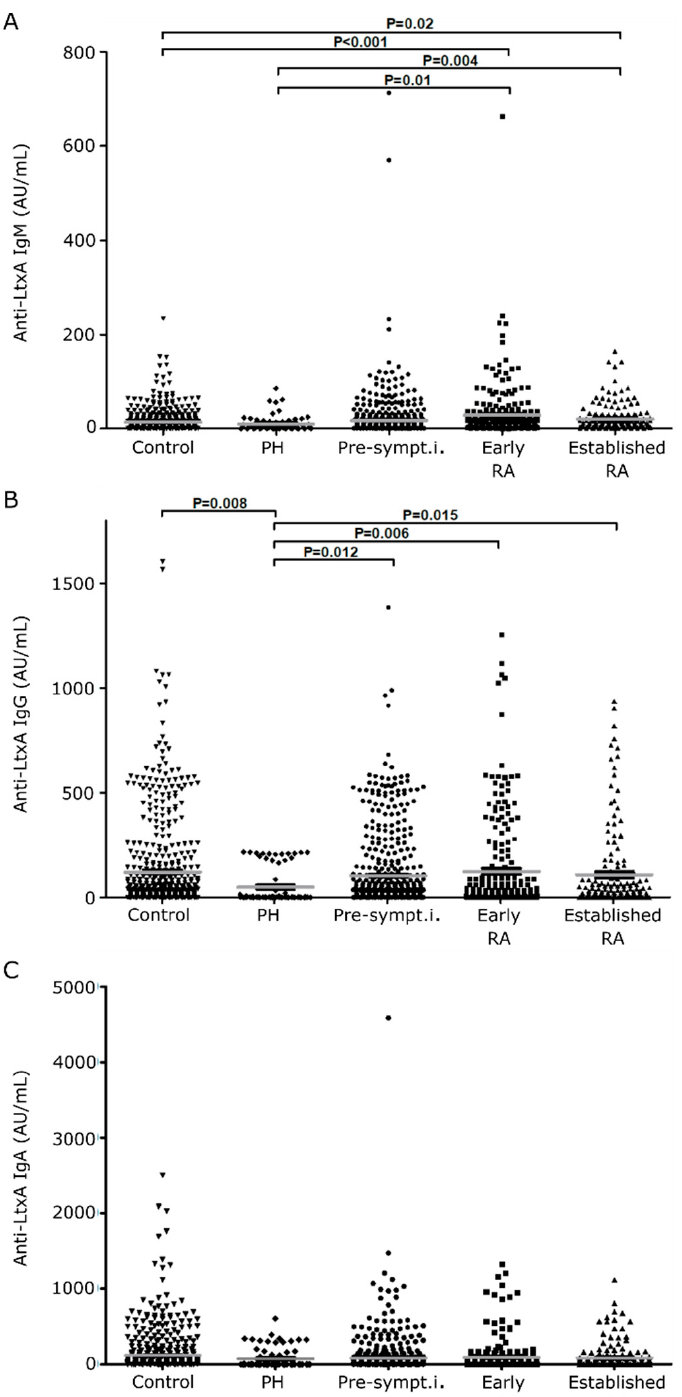
Figure 1. Levels of anti-LtxA antibodies according to isotype in the study groups. Levels of anti-LtxA IgM ( A ), anti-LtxA IgG ( B ) and anti-LtxA IgA ( C ) in controls, n = 567; periodontitis healthy individuals (PH), n = 73; pre-symptomatic individuals (pre-sympt.i.), n = 526; early RA, n = 231; and established RA, n = 168.